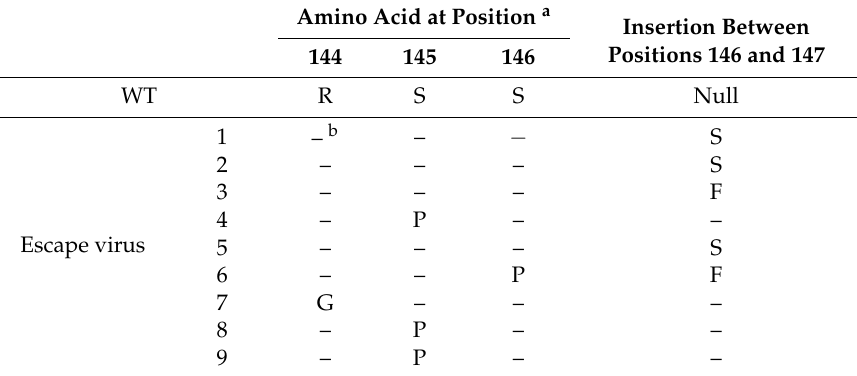
Table 6. Amino acid changes in escape mutant